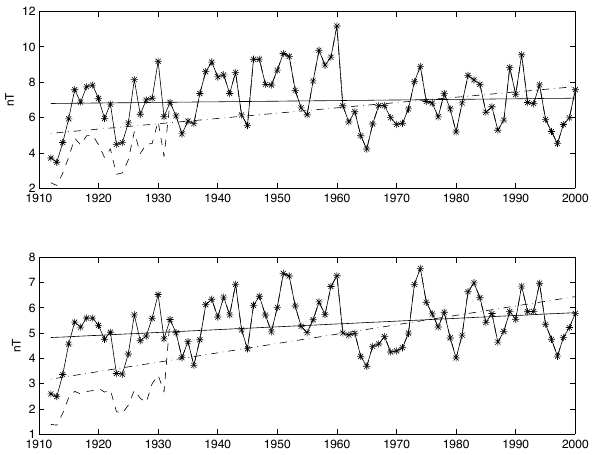
Fig. 7. Top: The corrected (line with stars) and uncorrected (dashed line) ESK IHV-raw indices in 1912–2000. The best fitting lines are included for each series (solid line for corrected IHV-raw, dash- dotted line for uncorrected IHV-raw). Bottom: The same for the ESK IHV-cor indices.